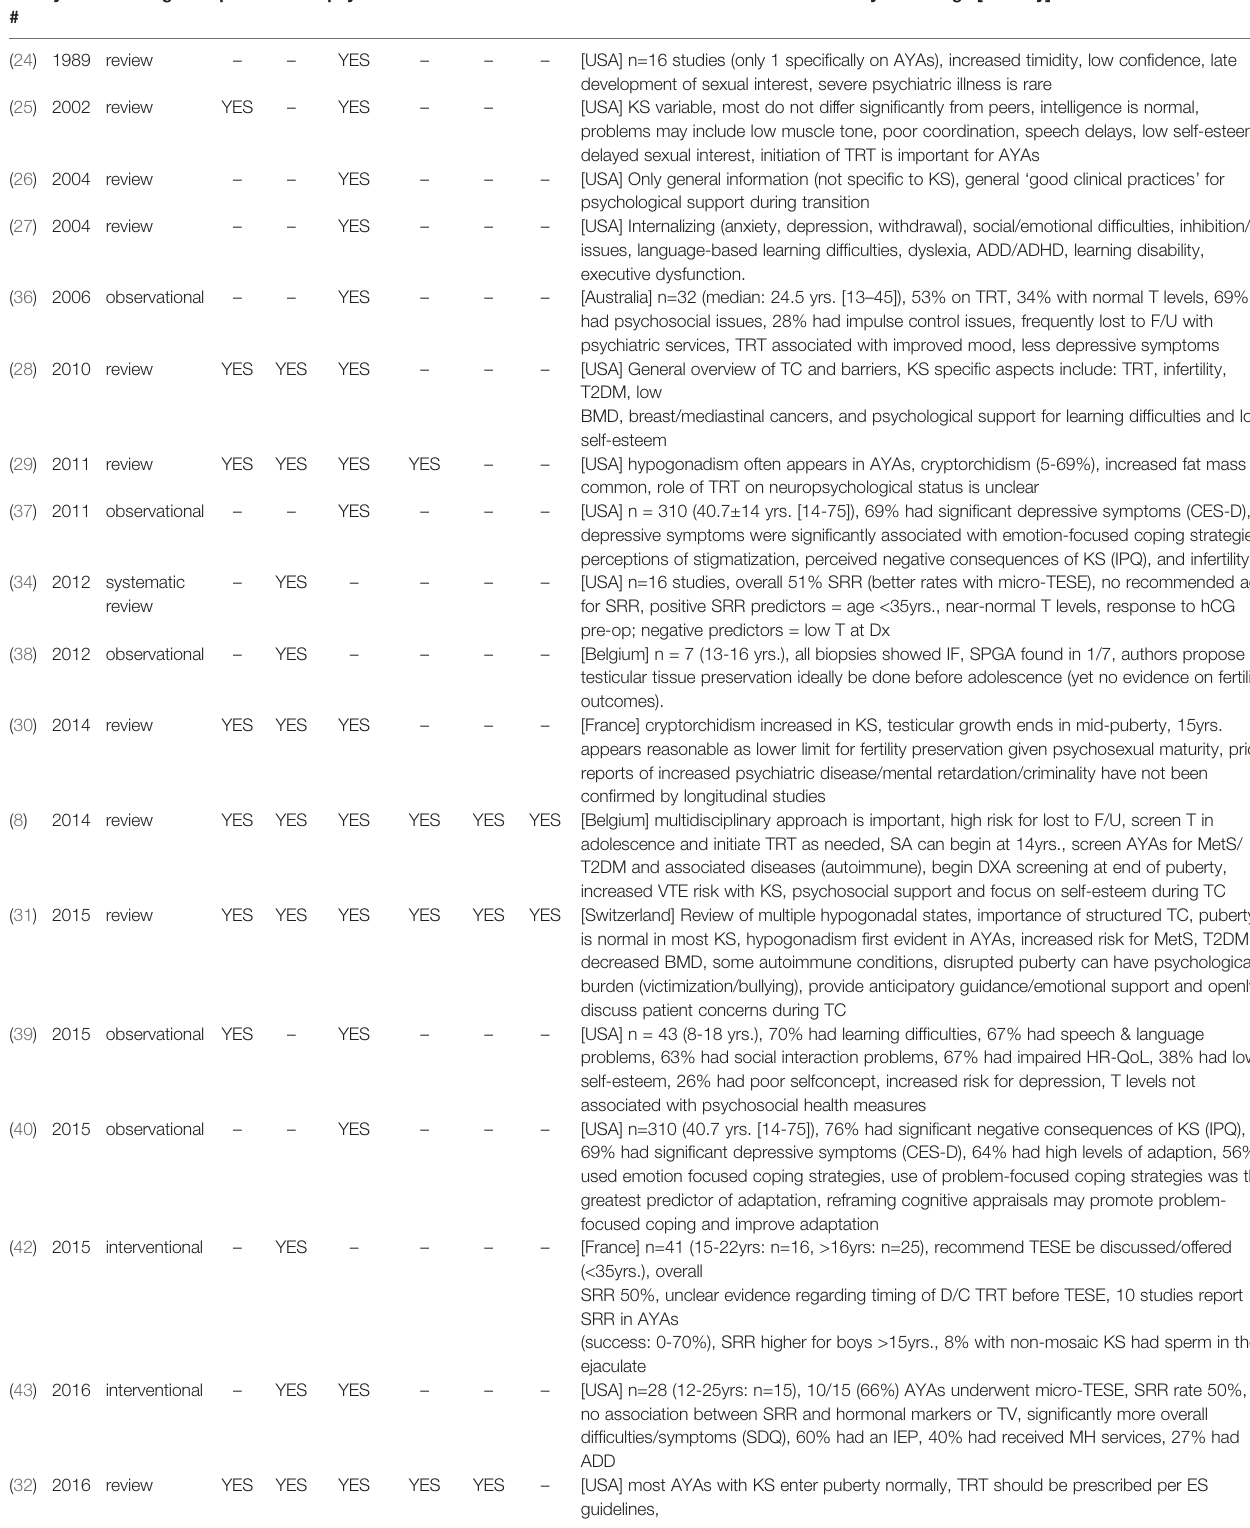
TABLE 1 | Summary of fi ndings from the systematic scoping review (n=21, 1987-2017). ref year #